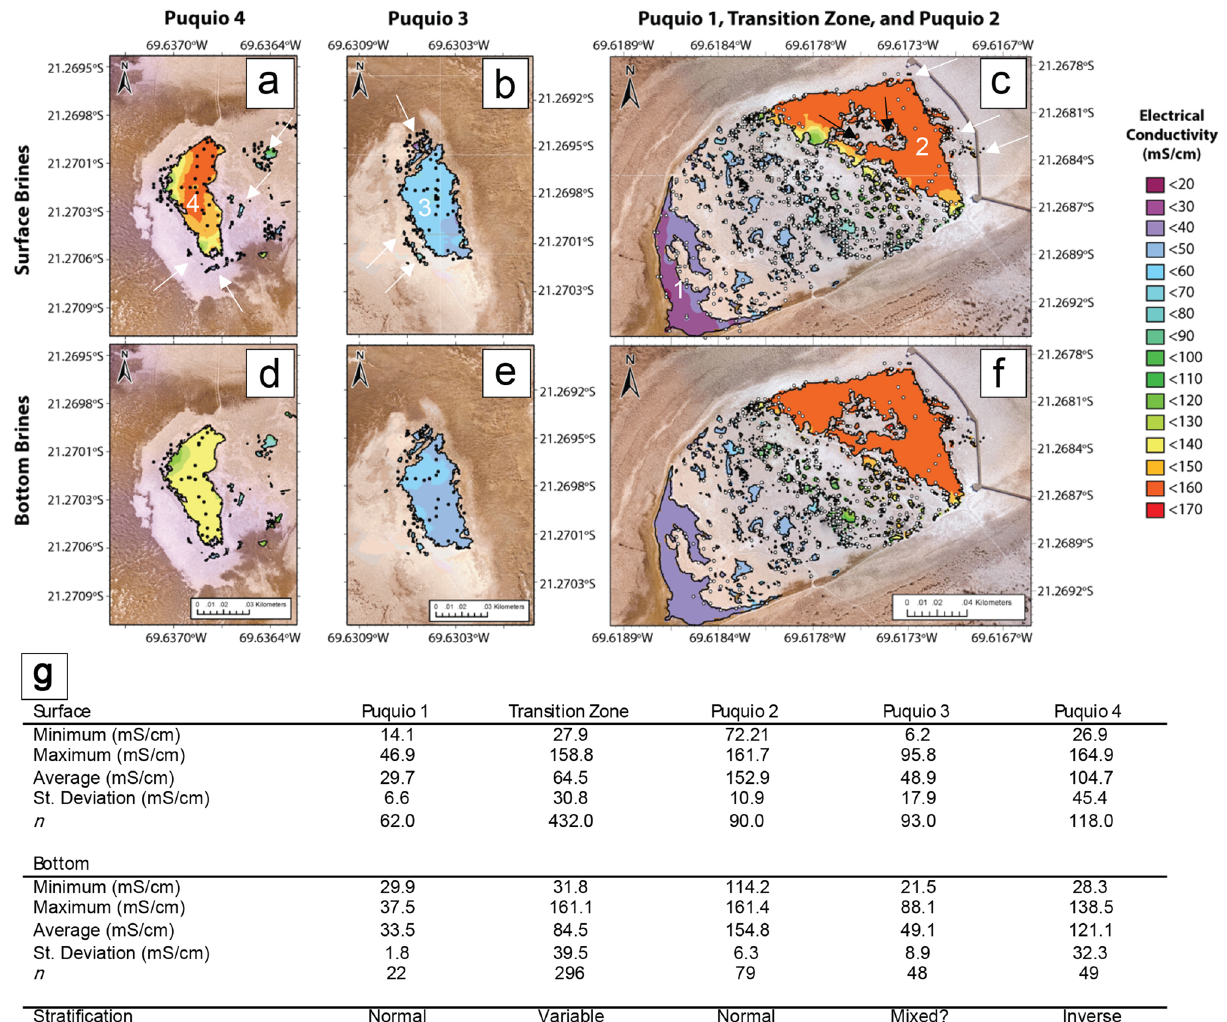
Figure 2. Contour maps of in situ electrical conductivity (mS/cm) in the Puquios. Measurement locations are shown as black dots (Puquios 3 and 4), and white dots (Puquios 1, 2, and the Transition Zone). Scale of all maps is 1:1180 km. Surface brine measurements are shown in ( a–c ) and bottom brine measurements are shown in ( d–f ). Maps were created in ArcGIS Pro https:// www. esri. com/ en- us/ arcgis/ produ cts/ arcgis- pro. Minimum and maximum measurements of electrical conductivity (mS/cm) in the surface and bottom brines of each of the Puquios during the November 2017 field campaign are shown in ( g ). Stratification was assessed following the methods of Babel (2004) and refers to the main lagoon waters and the smaller peripheral